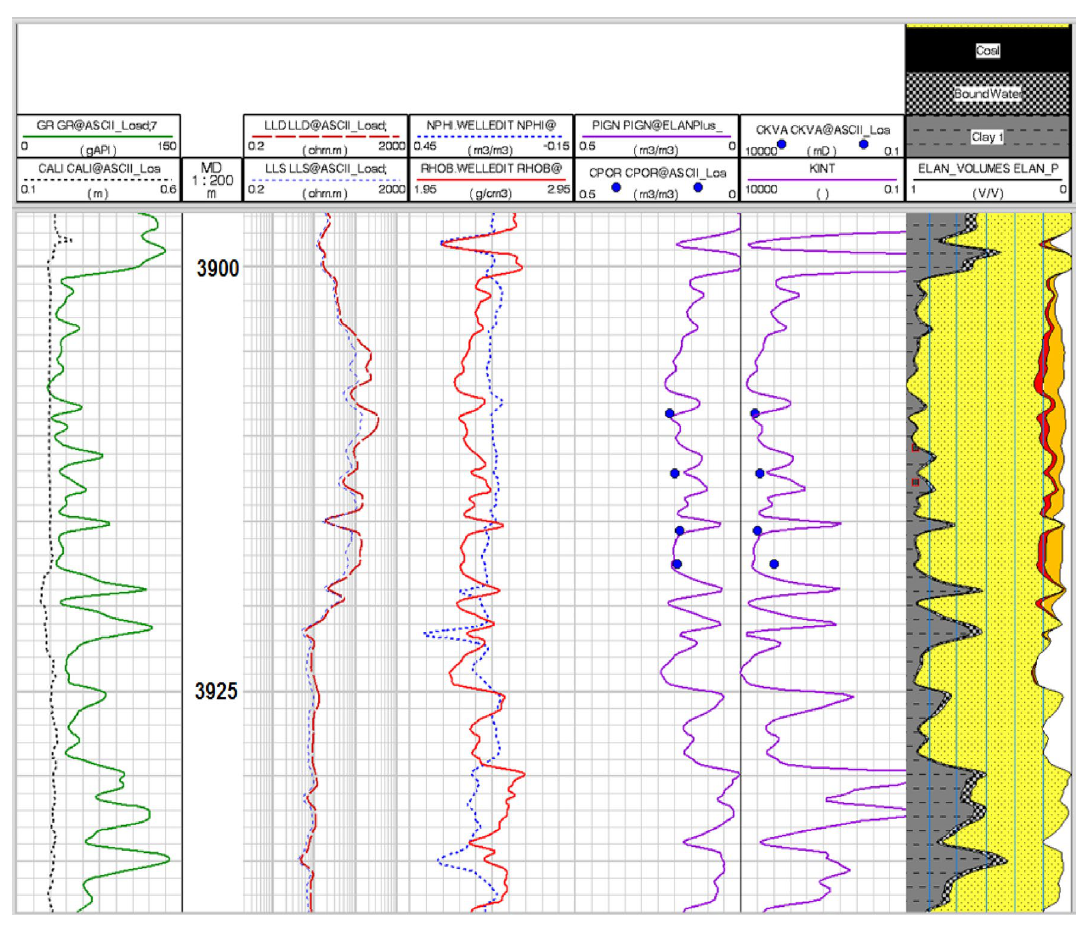
Fig. 3 ELAN interpretation and permeability prediction in